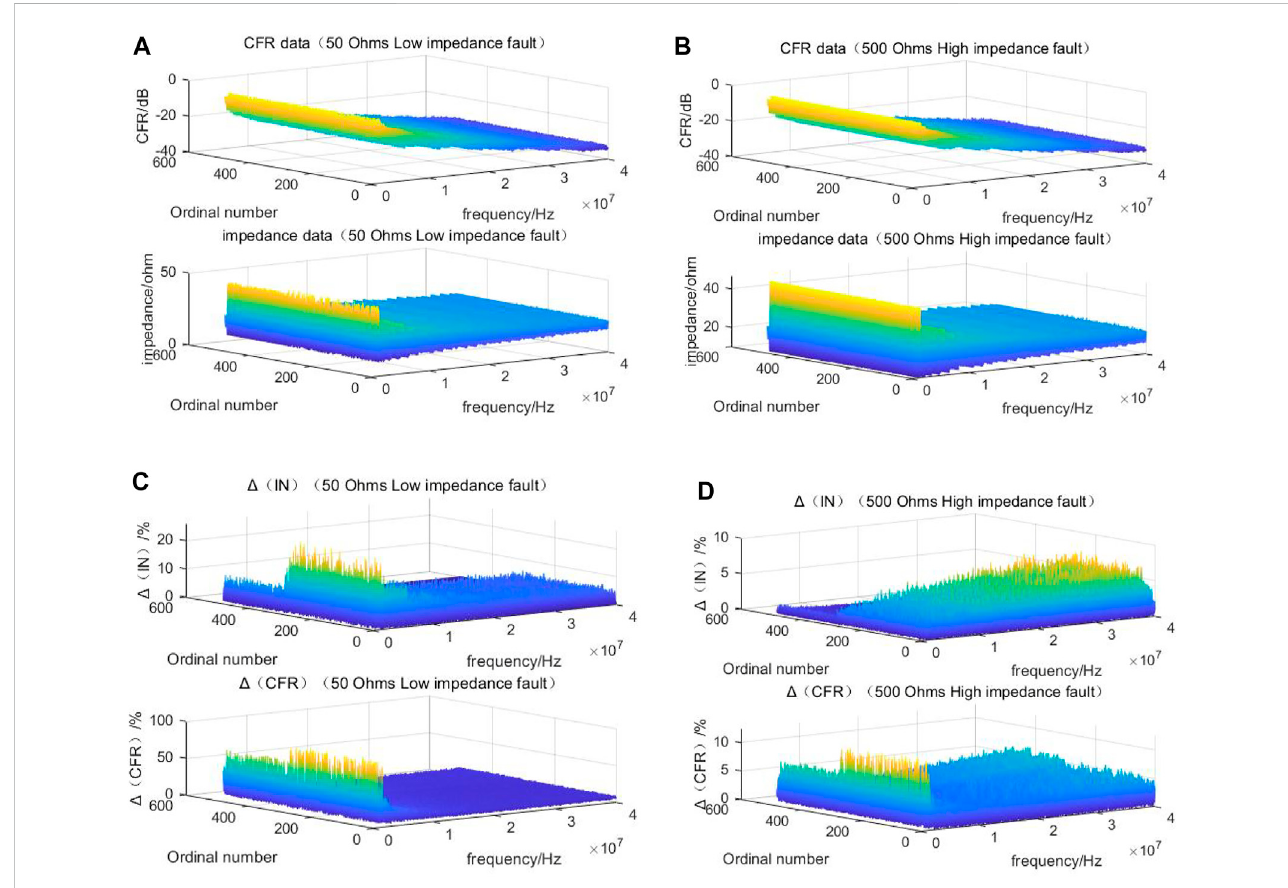
FIGURE 11 500 sets of CFR, impedance data and Δ values. (A, B) are CFR data and impedance data for low impedance and high impedance fault, respectively (C, D) are Δ values for low impedance and high impedance fault,